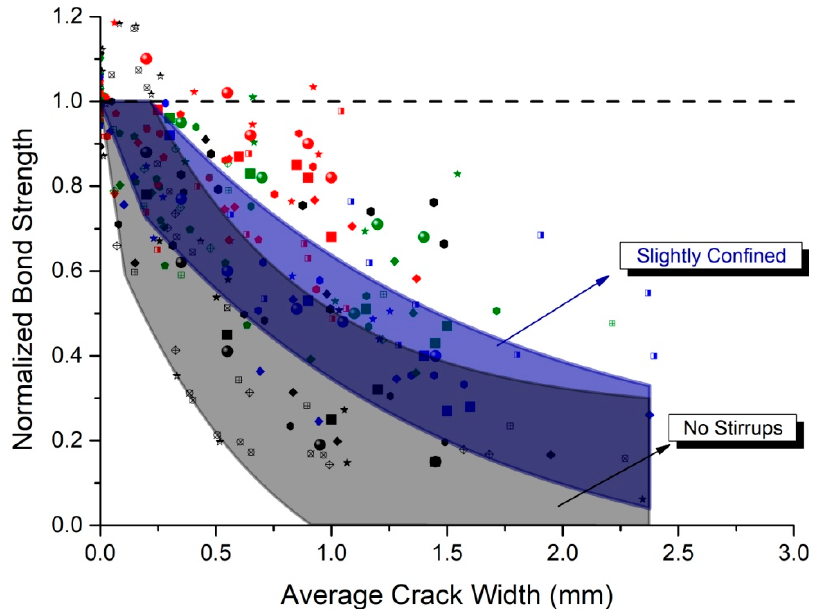
Figure 14. Proposed predictive zones of bond loss in relationship to crack width—in the case of existing aging structures.